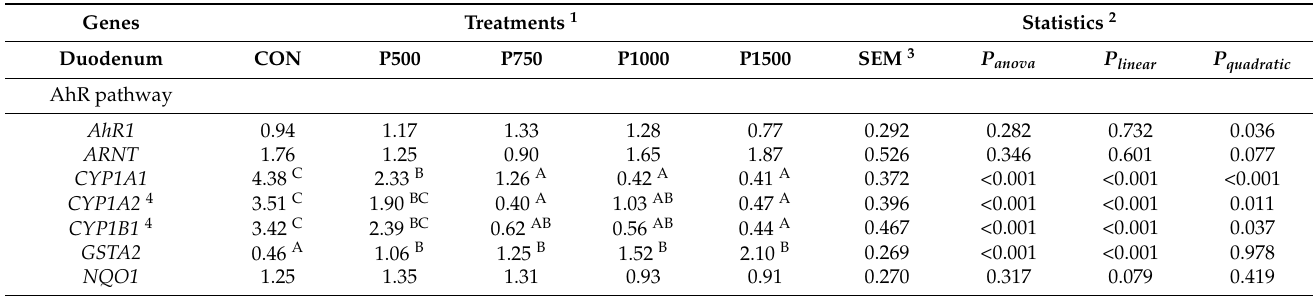
Table 4. Relative expression of AhR pathway genes in the layers’ duodenum at the 8th week of the experiment.